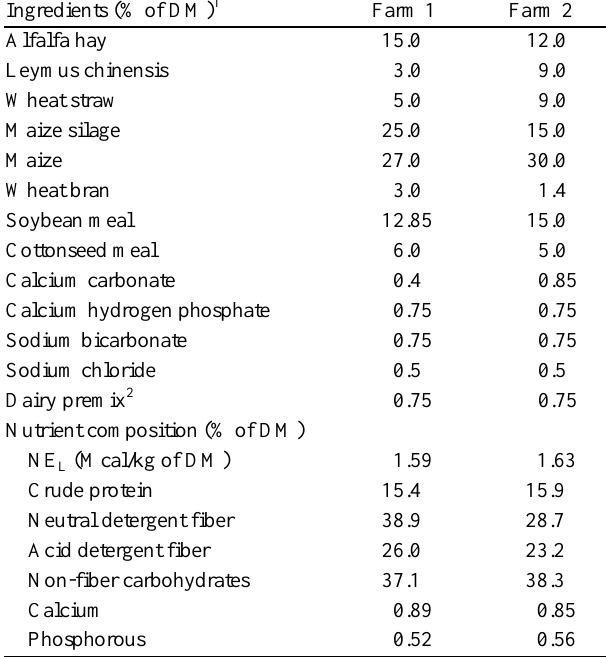
Table 1. Ingredient and nutrient compositions of